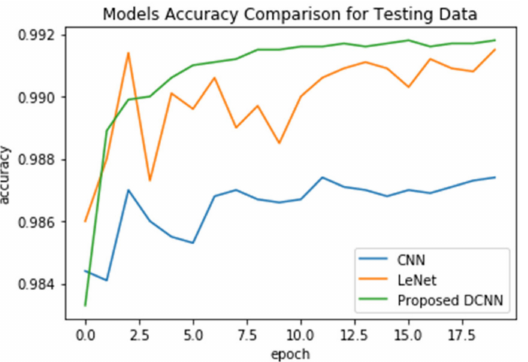
Figure 13. Accuracy Comparison of CNN, LeNet, and the Proposed DCNN on the Pashto Digits